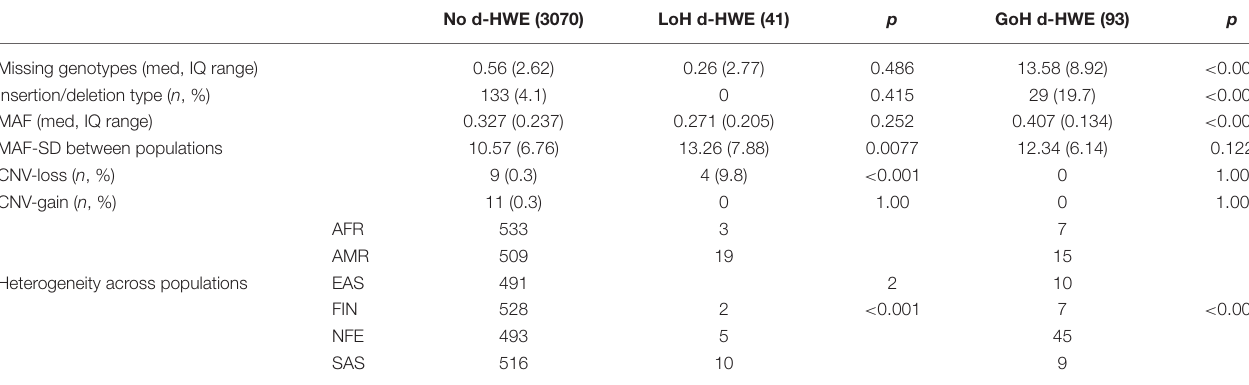
TABLE 1 | Causes of HWE departure associated with reduced or excess heterozygotes.